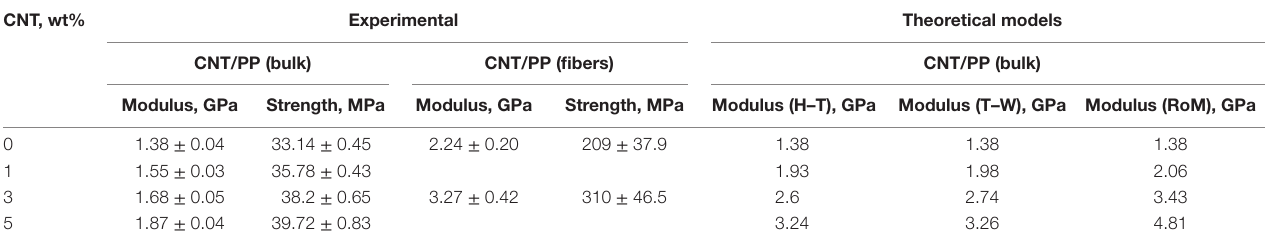
TaBle 1 | Tensile properties of cnT/PP composites: bulk vs. fibers and experiments vs. models. cnT, wt% experimental Theoretical models